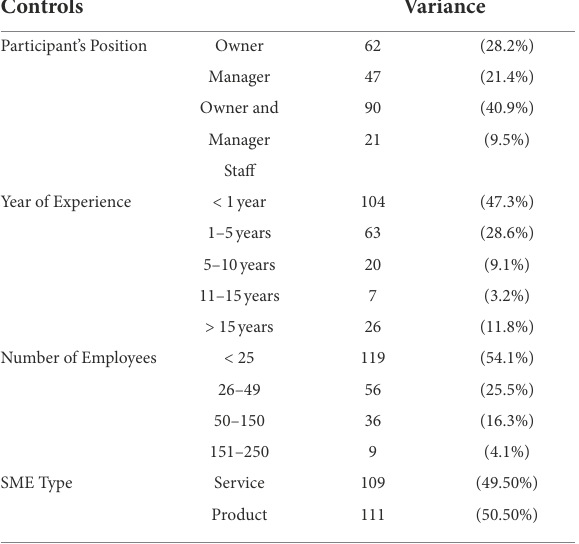
TABLE 1 Demographic information. Controls